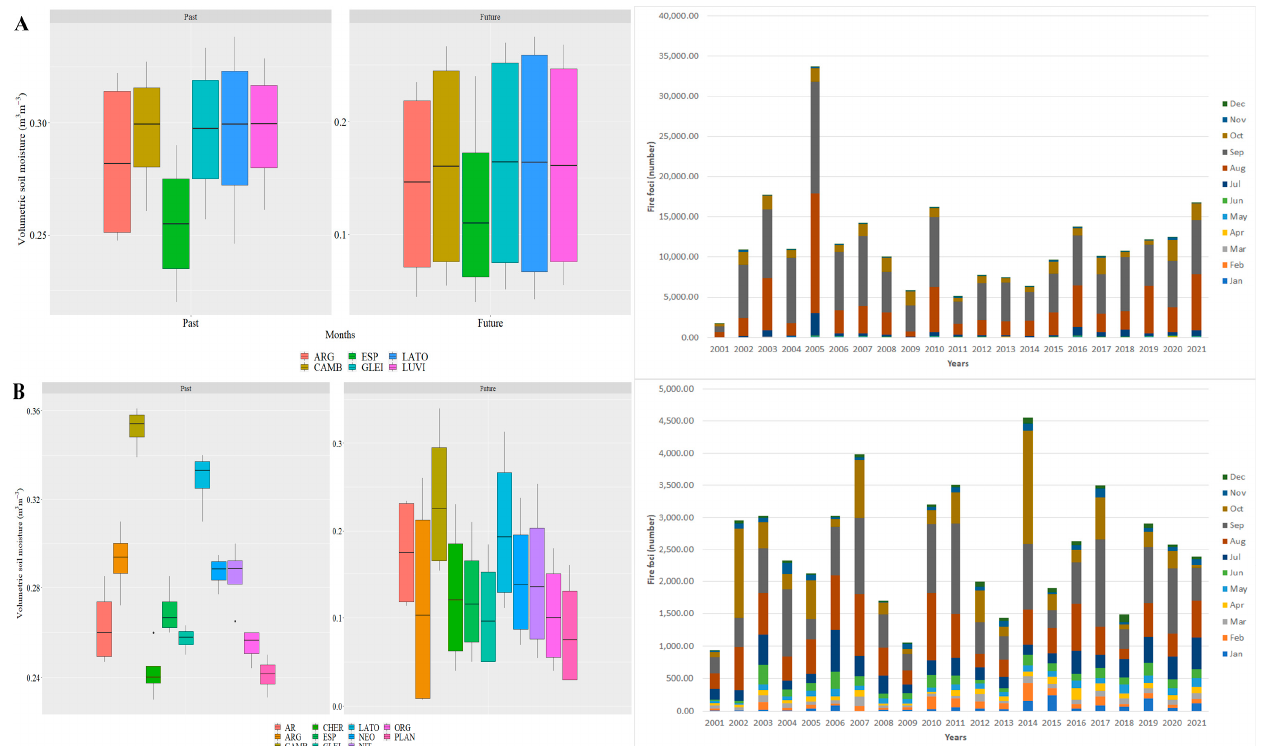
Figure 12. Boxplot graphs of VSM variation (m 3 m − 3 ) for soil types for the states of Acre ( A ) and Rio de Janeiro ( B ) and, on the right, the monthly temporal distribution of fire foci.